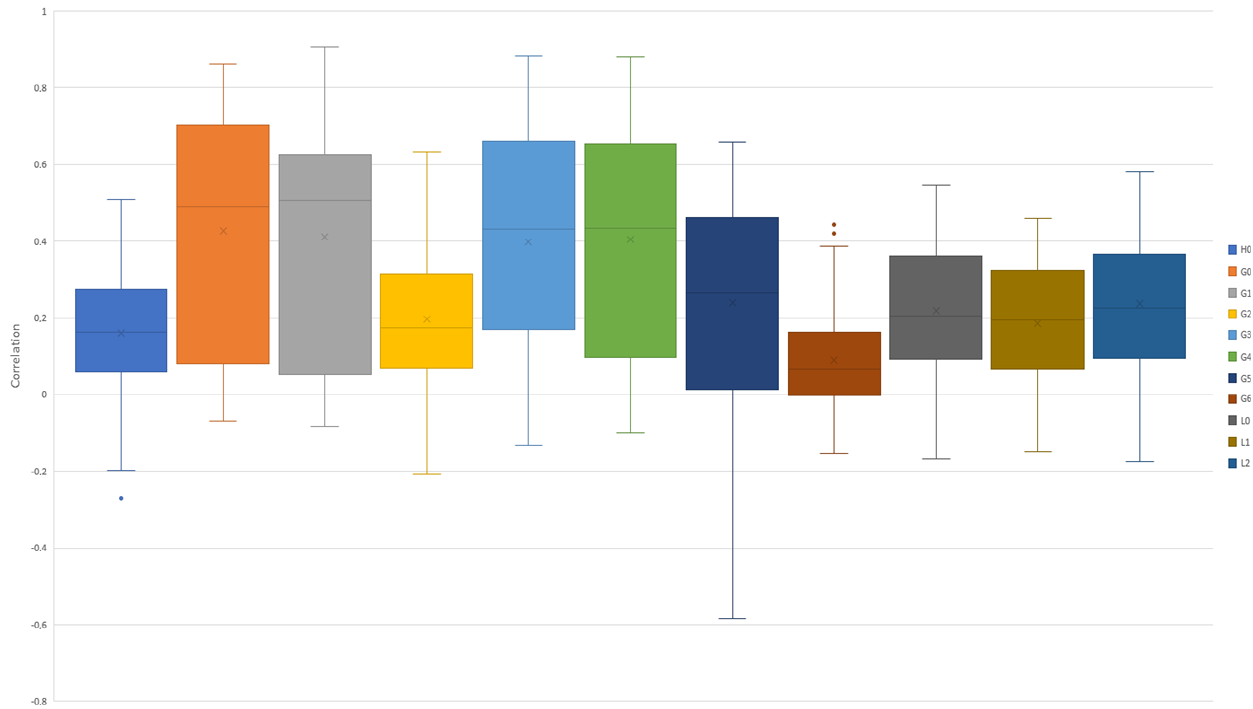
Figure 9. Correlation distribution from load profiles to standard load